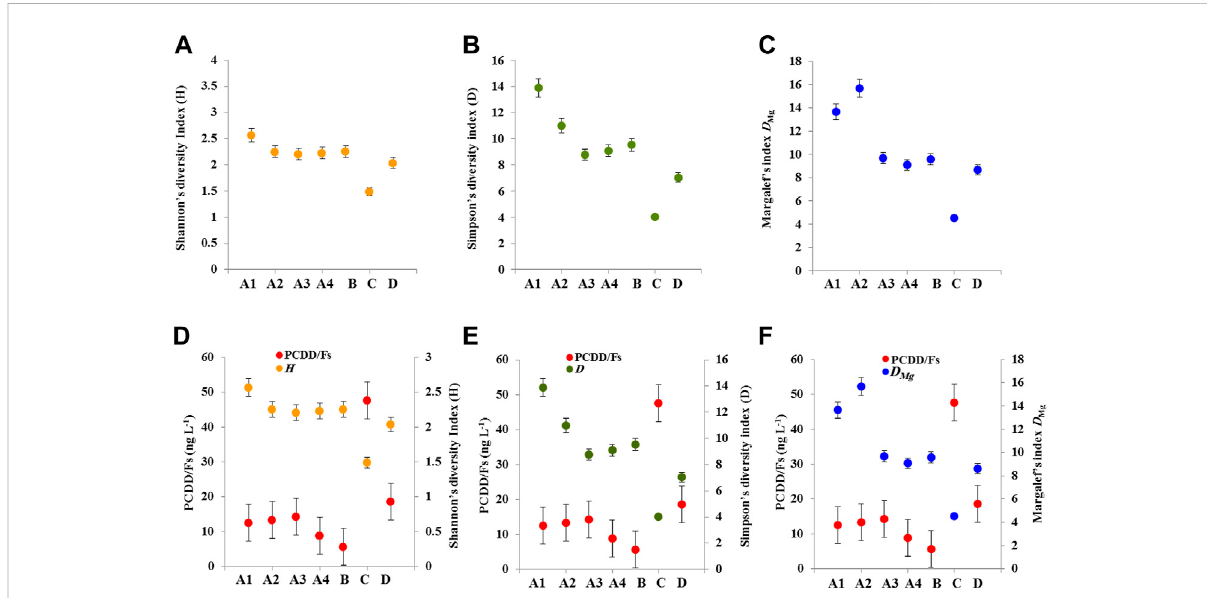
FIGURE 3 Diversity indices of microbial communities as a function of contamination level with PCDD/Fs in different sites. (A – C) Diversity and bacterial speciesrichnesswereevaluatedbyTheShannon ’ sdiversityIndex(H),TheSimpson ’ sdiversityindex(D)andMargalef ’ sindex D Mg . (D – F) Therelations between diversity and richness species, H, D and D Mg , and the concentration of PCDD/Fs in different sites. Values are means ± S.D ( n = 3). Diversity indices were signi fi cantly lower in soil samples that are contaminated with the highest concentration of PCDD/Fs ( p < 0.01